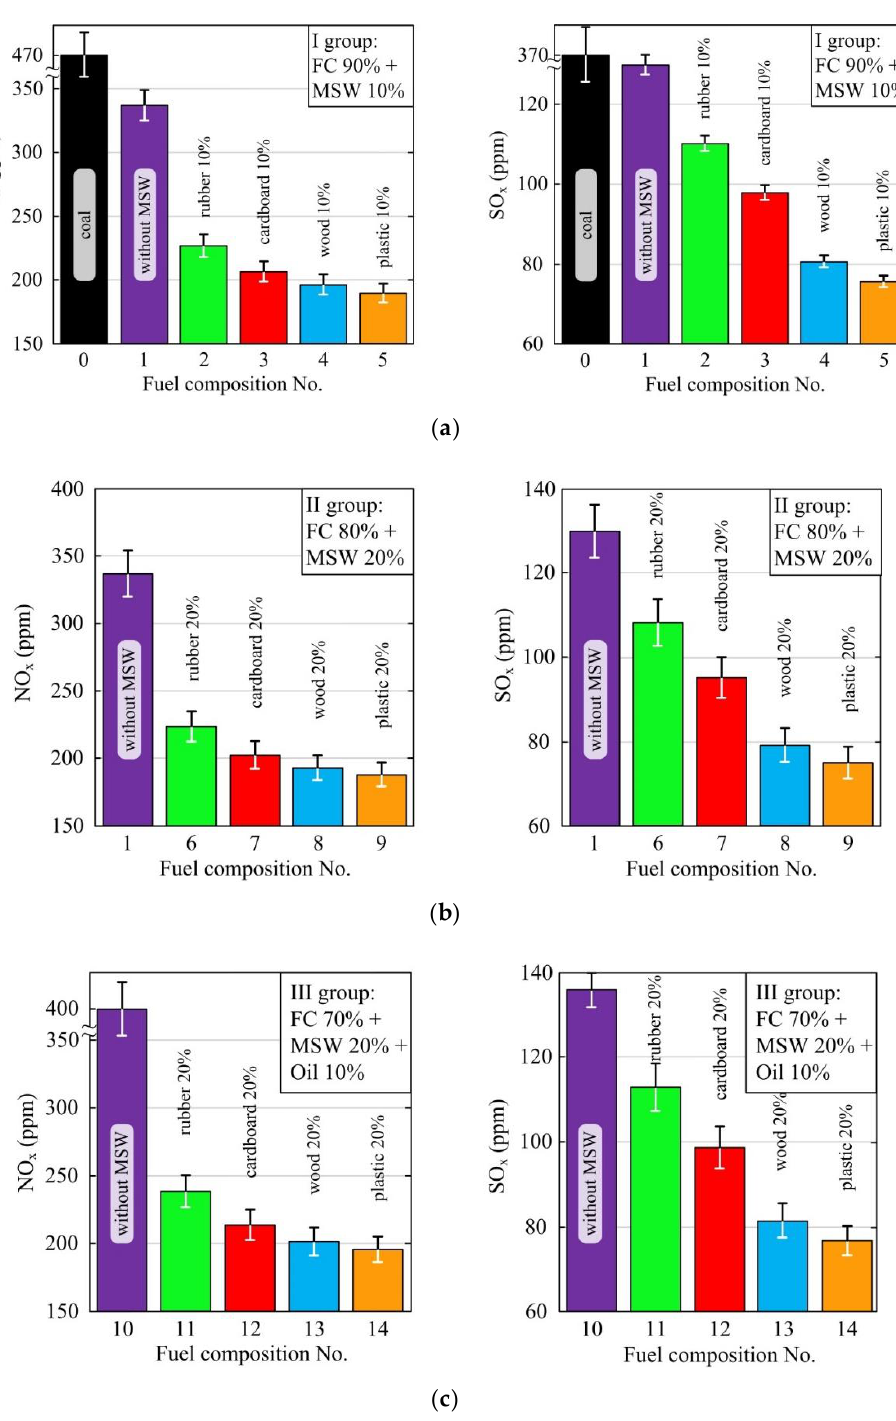
Figure 5. Concentrations of nitrogen and sulfur oxides in flue gases of dry coal and fuel slurries: ( a ) group I; ( b ) group II; and ( c ) group III (composition No. 0—data [31] for coking coal).